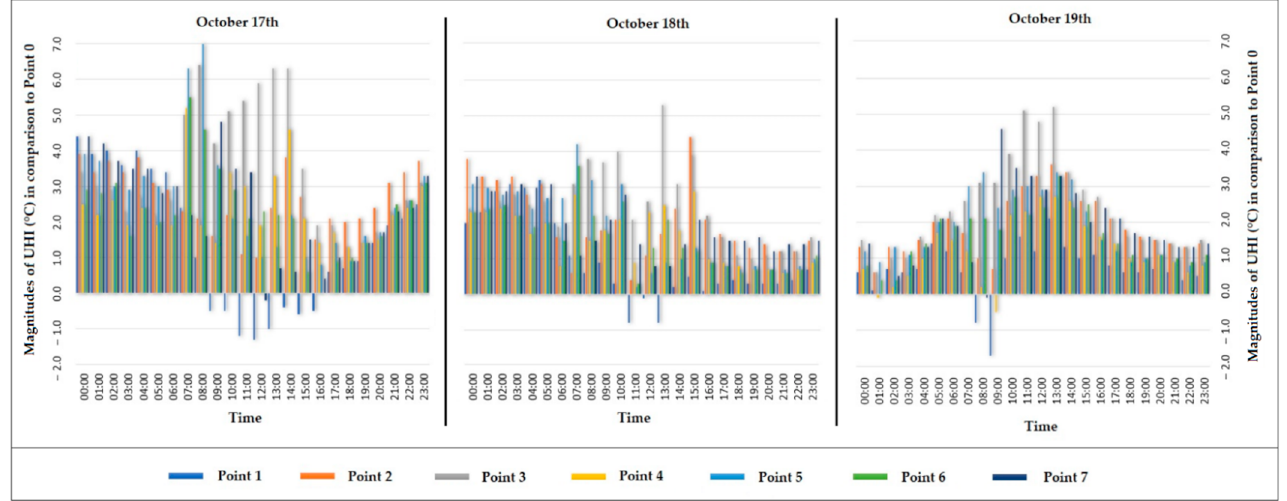
Figure 11. Hourly magnitude of the Ta and UHI of the seven points in Balneário Camboriú,